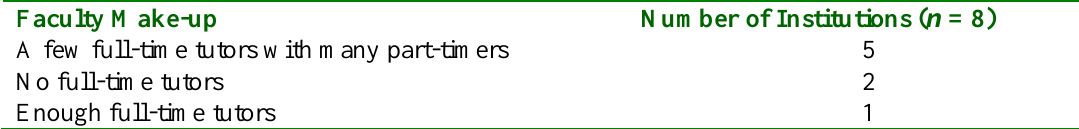
Table 15. Faculty make-up among Chinese online institutions Faculty Make-up